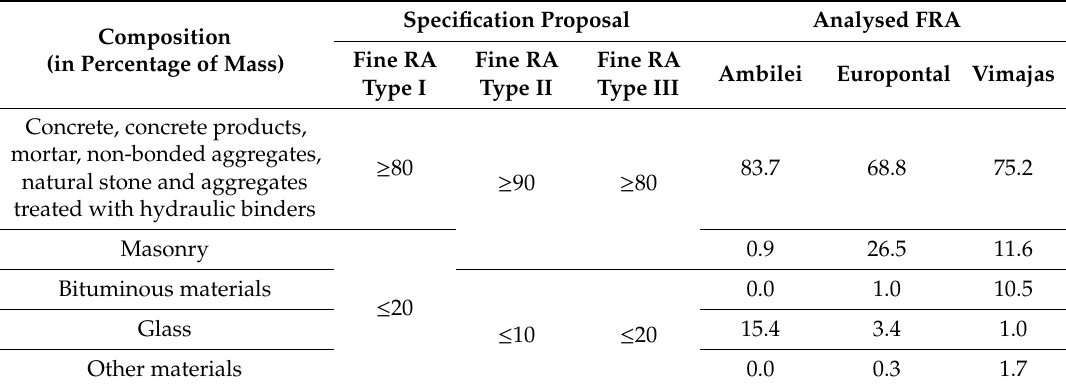
Table 8. Composition of the FRA